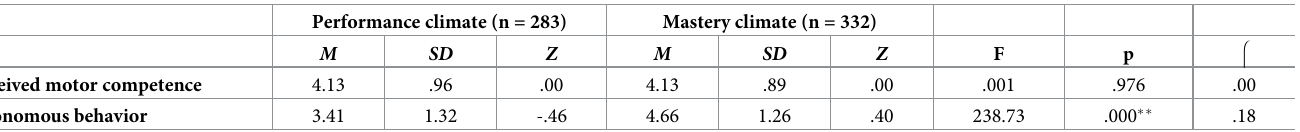
Table 3. Multivariate analysis according to cluster based on the scales ASCQ and